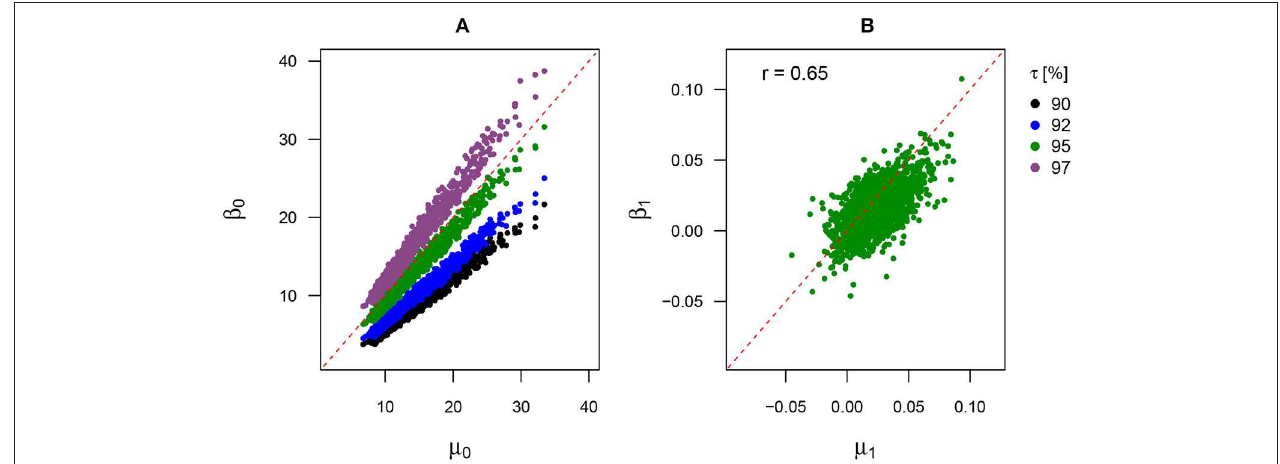
FIGURE 3 | Scatter plots for the relationship between the location parameter of the GEV and QR for (A) the respective intercepts ( µ 0 , β 0 ) and (B) the respective trend coefficients ( µ